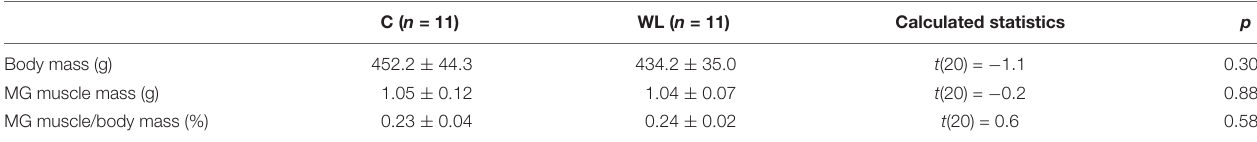
TABLE 1 | Medial gastrocnemius muscle characteristics in the studied groups of